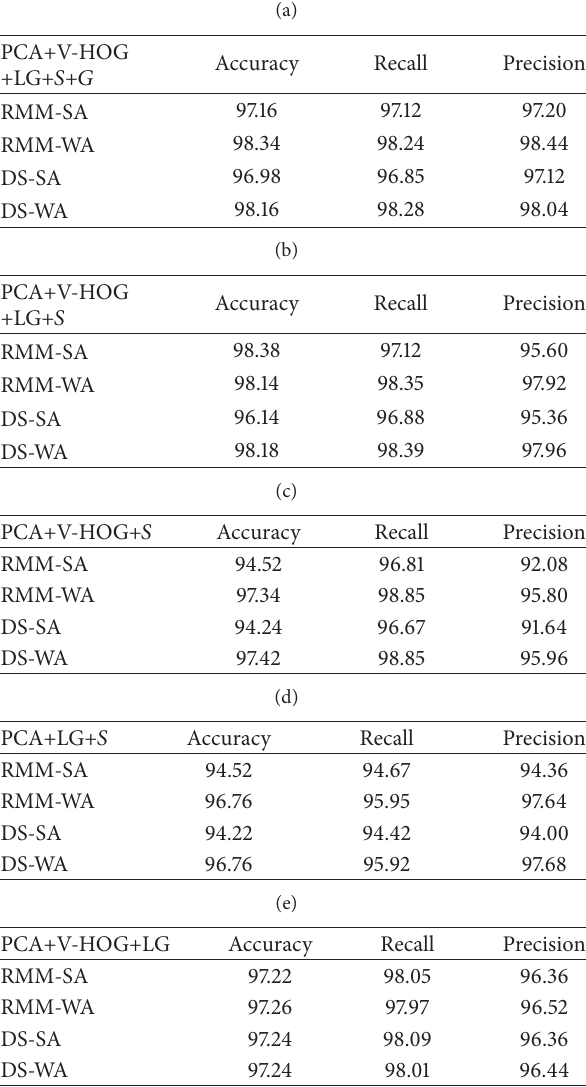
Table 13: Performance of the proposed ensembles for the far region. Table 14: Diversity measures for the far region: (a) double fault and (b) correlation